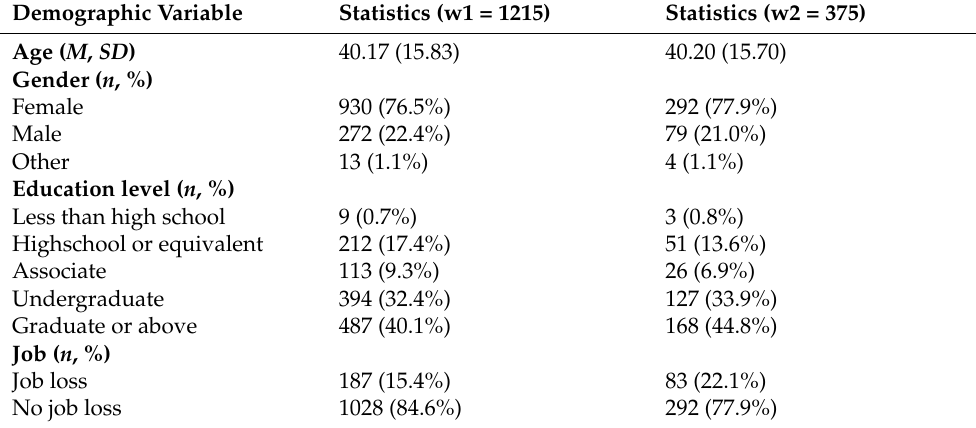
Table 1. Demographics characteristics of North Americans in first (w1) and second (w2)